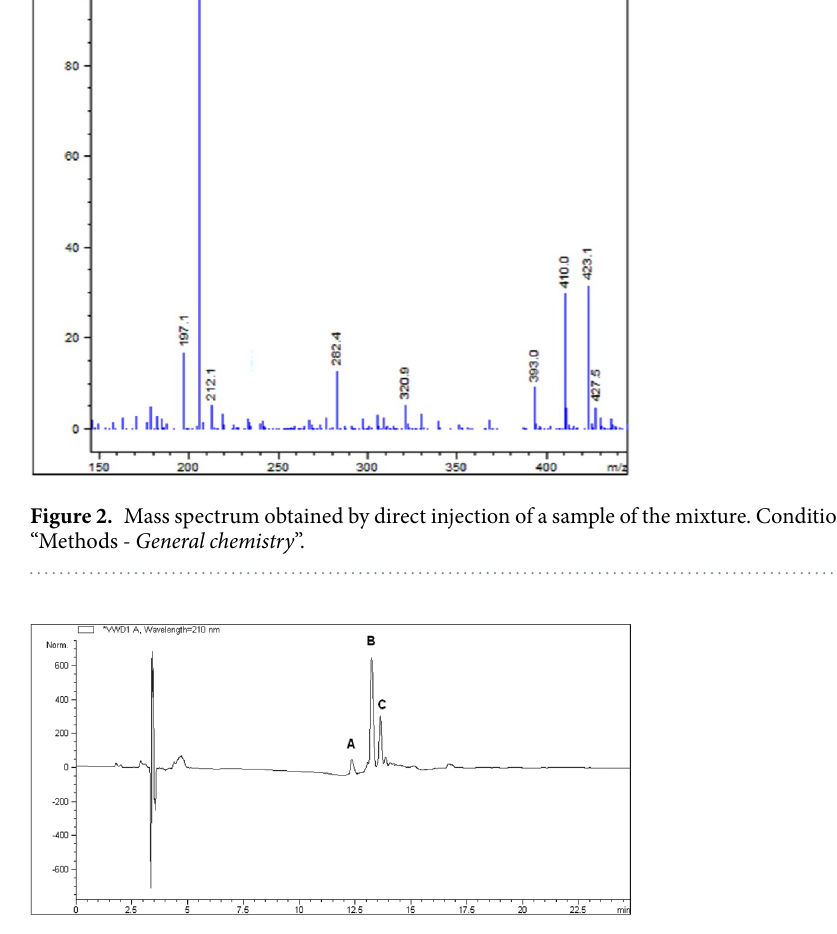
Figure 3. Chromatographic profile obtained after blank substraction of a sample of the first batch (10 mg/ mL) by LC–MS: A (t R = 12.40 min) monomer ( 1 ); B (t R = 13.34 min) = dimer; C (t R = 13.74 min) = trimer. Chromatographic method and conditions are reported in “Methods - Chromatographic separation”